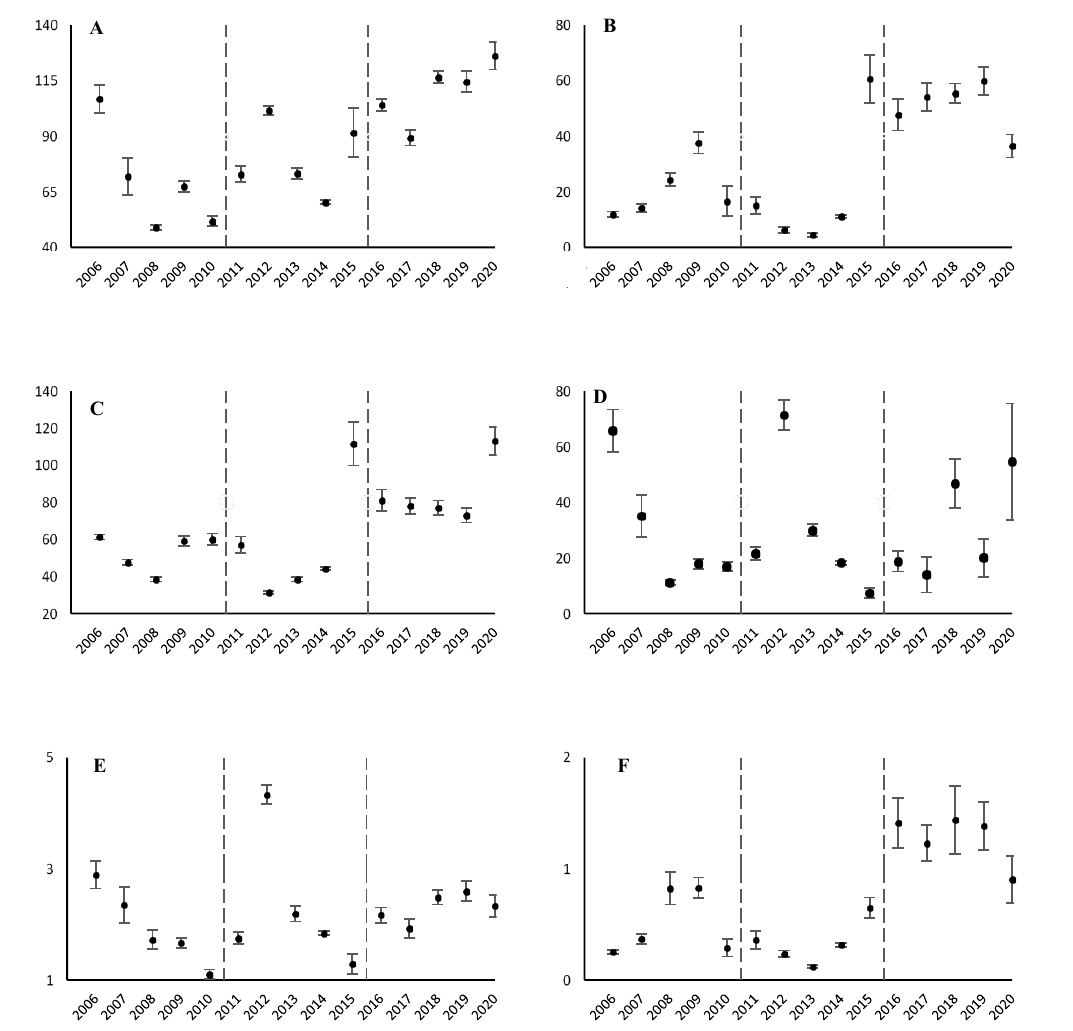
Figure 1. Annual N, P, and K stoichiometry and ratios. The solid black circles indicate the average value for that year and the lines indicate the value of SE. SE is derived based on the annual data volume of N, P, and K. The content of available nitrogen ( A ) at all years. The content of available phosphorus ( B ) at all years. The content of available potassium ( C ) at all years. The stoichiometric ratio of N and P ( D ) at all years. The stoichiometric ratio of N and K ( E ) at all years. The stoichiometric ratio of P and K ( F ) at all years.